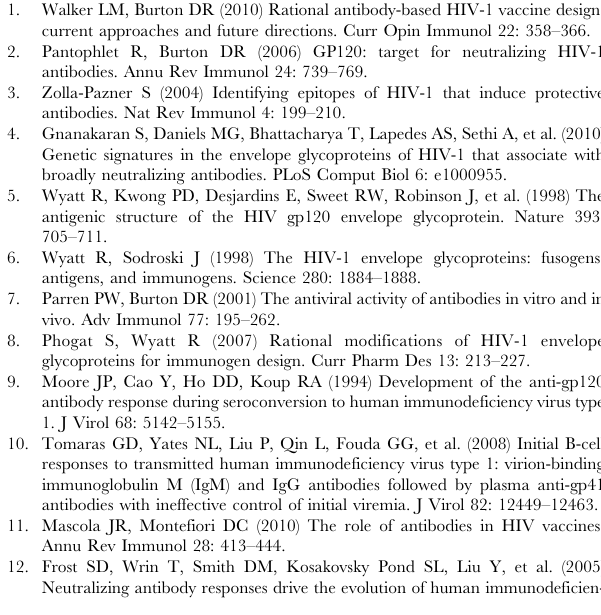
Figure S2 Effect of Y681H substitution on exposure of CD4-induced epitopes. The effect of Y681H on relative exposure of coreceptor binding sites was assessed by examining Env sensitivity to coreceptor mimetic 17b MAb. The percent inhibition in infectivity of Env-pseudotyped viruses in TZM-bl cells indicated on Y-axis was assessed by measuring the reduction in relative luminescence units (RLU) at various concentration of antibody indicated on X-axis. Experiments were done in duplicates and repeated at least three times. Note that Env expressing H681 are more sensitive than Y681 versions suggesting shift towards CD4-bound-like structure with the coreceptor binding site more exposed. (TIF) Figure S3 Effect of Y681H on infectivity of Env-pseudo- typed viruses in TZM-bl cells. Effect of Y681H substitution on infectivity of Env-pseudotyped viruses in different genetic backgrounds with equal virus particles (p24) was assessed in TZM- bl cells. TND L669S Env that was shown by Shen et al [44] to significantly enhance Env sensitivity to neutralizing antibodies was used as control. Percent infection of Y681H mutants or H681Y mutant (in case of 4.J2) relative to their wild type counterparts is represented on Y-axis.